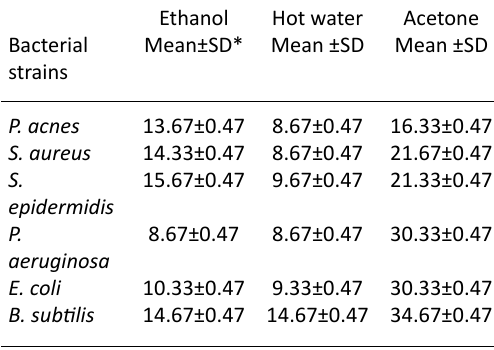
Table 1. Screening of antibacterial susceptibility of Camellia sinensis extracts using three different solvents against bacterial